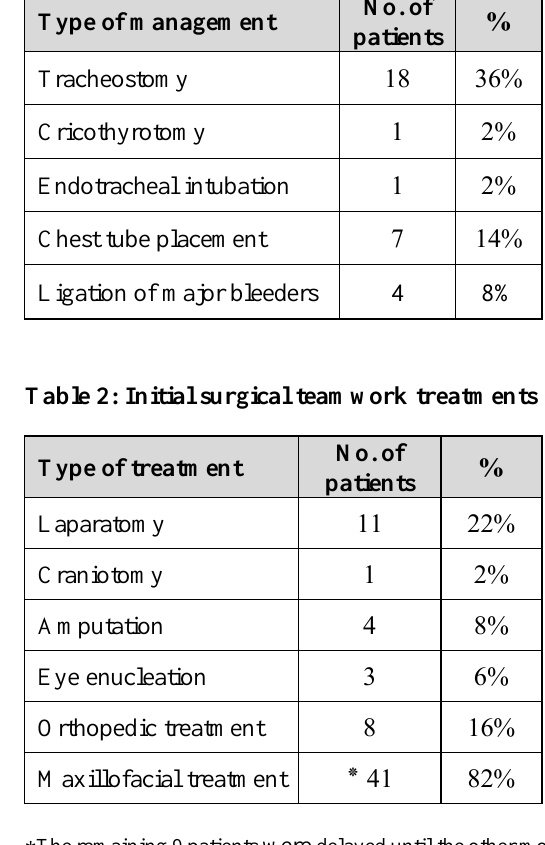
*The remaining 9 patients were delayed until the other more urgent surgeries done for them